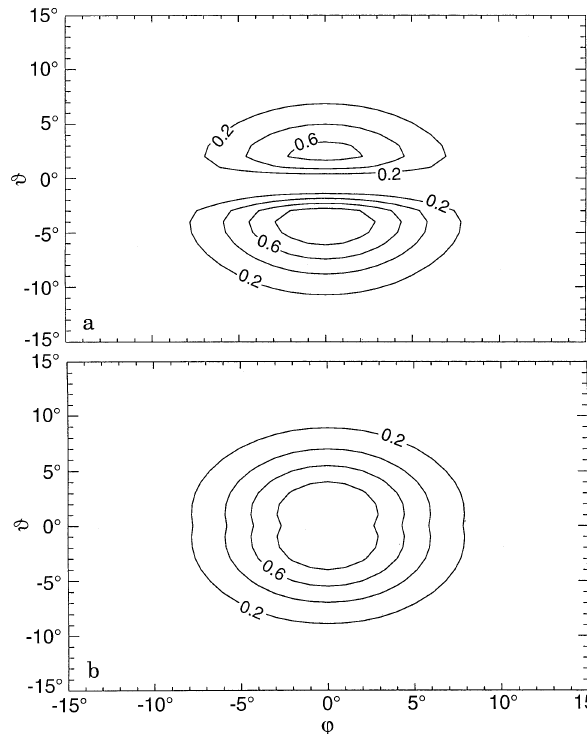
Fig. 5. a Integrand of Eq. 10, i.e. the antenna pattern folded with the backscatter cross-section as a function of the angles (cid:48) and (cid:117) for k (cid:49)(cid:33)(cid:51) / k " 0.01 and a radar elevation angle (cid:98) " 30 ° . b Same as a , but for a radar elevation of angle of 90 ° (vertical